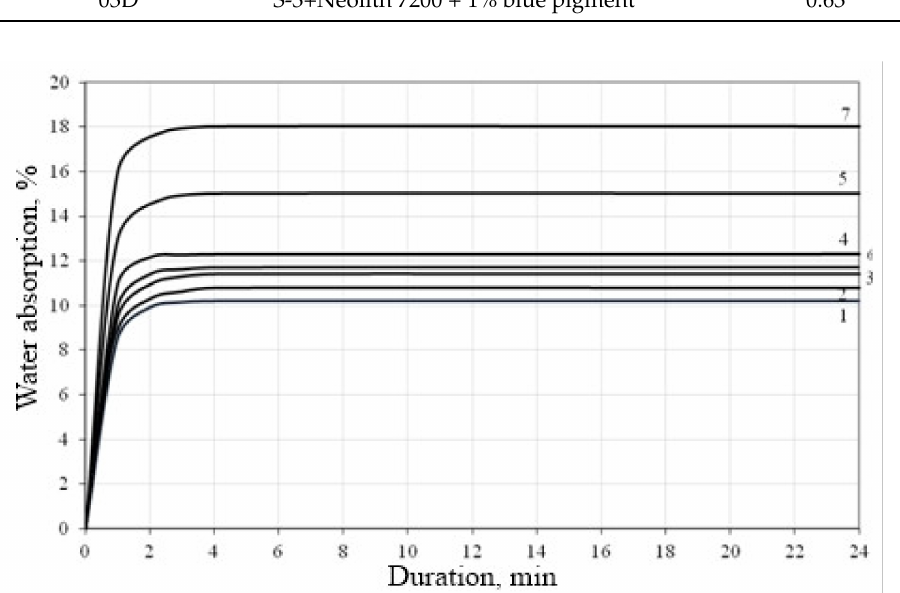
Figure 10. Water absorption of the lime composites: 1—03C+Kratasol; 2—03C+S-3; 3—03C+Hidetal P-4; 4—03C+SP-3; 5—03A; 6—03D+S-3;